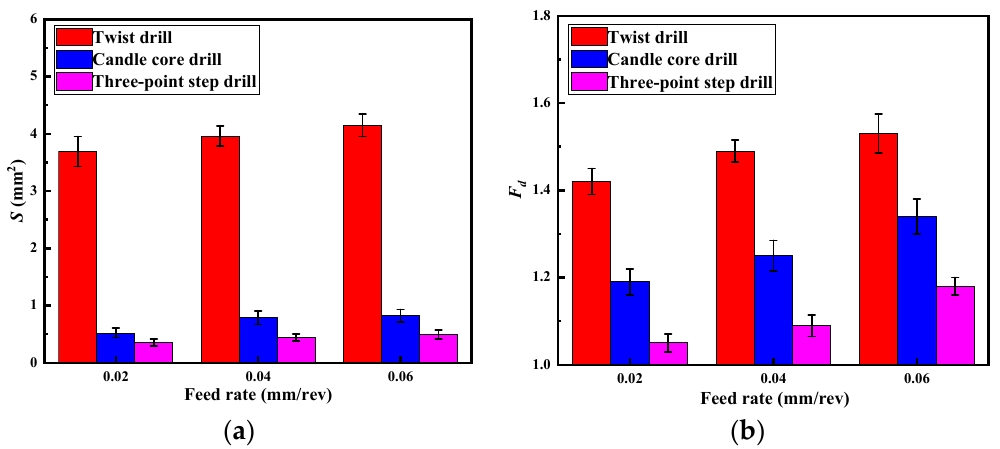
Figure 10. Damage variations of the three drills: ( a ) burrs area, ( b ) delamination factor.